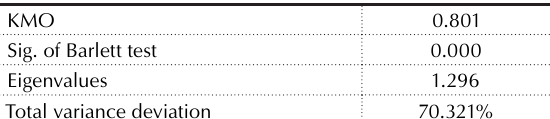
Table 2. Exploratory factor analysis (EFA) for the independent variable